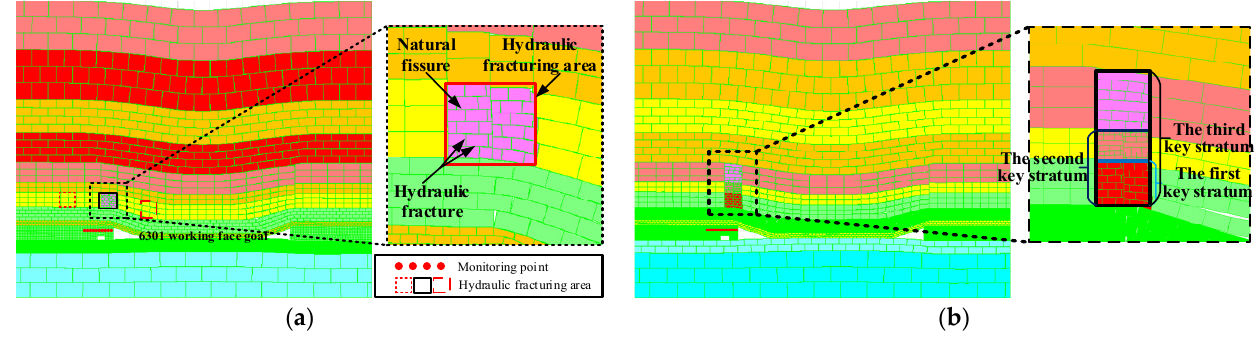
Figure 6. Uniaxial compression test and stress–strain curve of rock mass; ( a ) The arrangement angle of hydraulic fracturing roof cutting; ( b ) Hydraulic fracturing roof cutting height (stratahorizon).